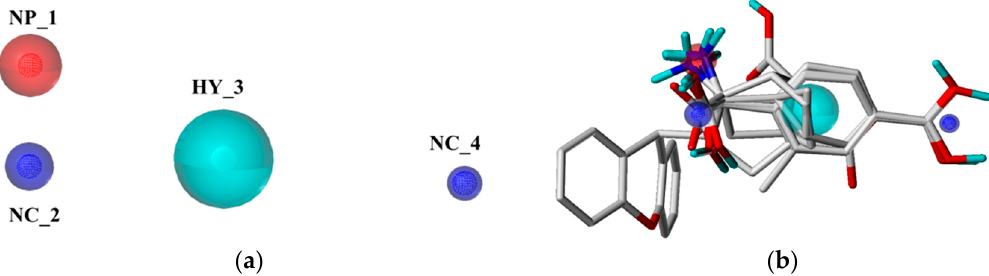
Figure 2. ( a ) The optimal pharmacophore model of orthosteric site of mGluR I (model 03); ( b ) Model 03 mapped with the compound used to build model.